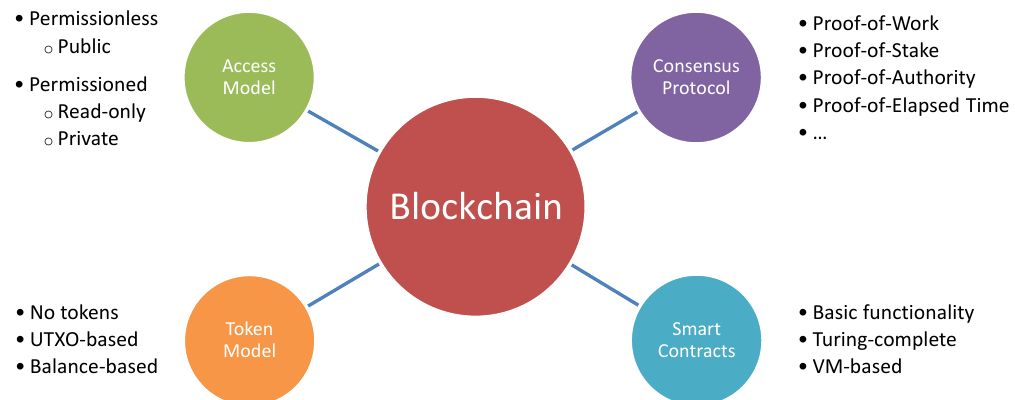
Figure 1. Basic elements of a blockchain